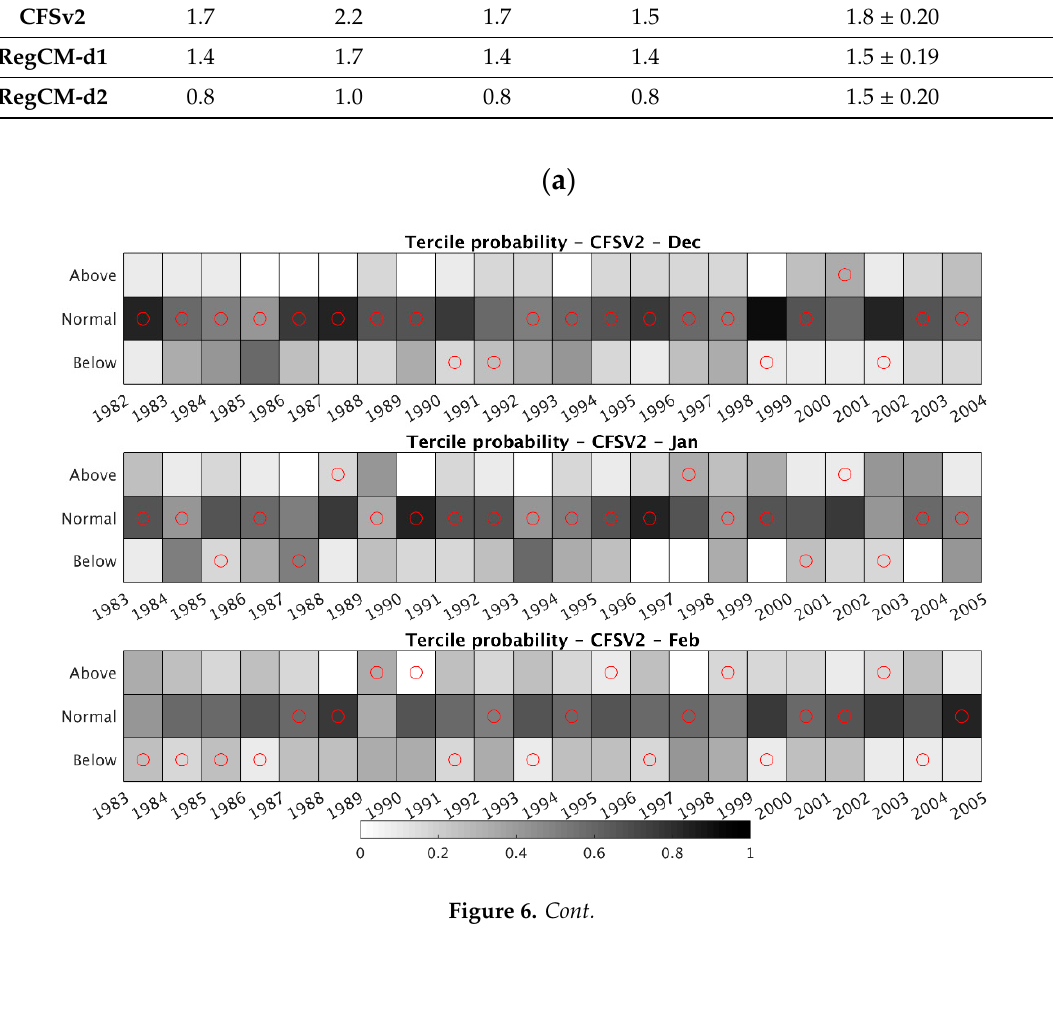
95th percentiles) of the reanalysis climatological period. Also, the inter-annual anomaly MAE of the three SFSs joined to the ensemble spread (i.e., standard deviation of the individual ensemble member’s